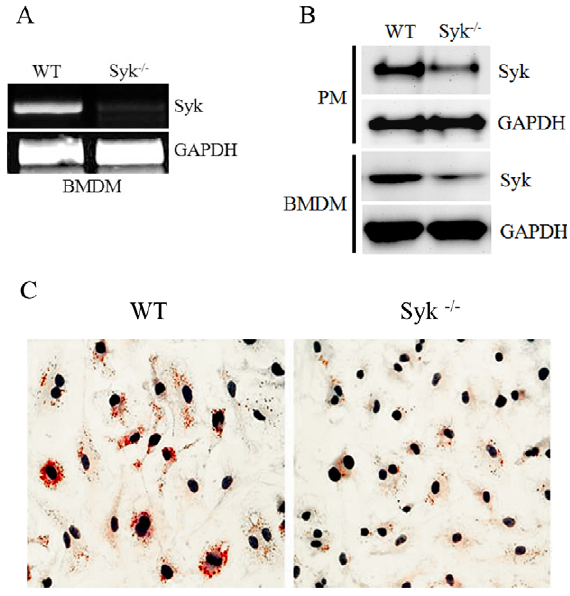
Figure 1. Reduced Syk expression in macrophages from Syk flox/ flox /LysM-Cre mice. ( A ) Total RNA was isolated from BMDM of Syk flox/ flox /LysM-Cre( 2 ) (WT) and Syk flox/flox /LysM-Cre( + ) (Syk 2 / 2 ) mice, and RT- PCR with Syk and GAPDH primers was performed. ( B ) Lysates